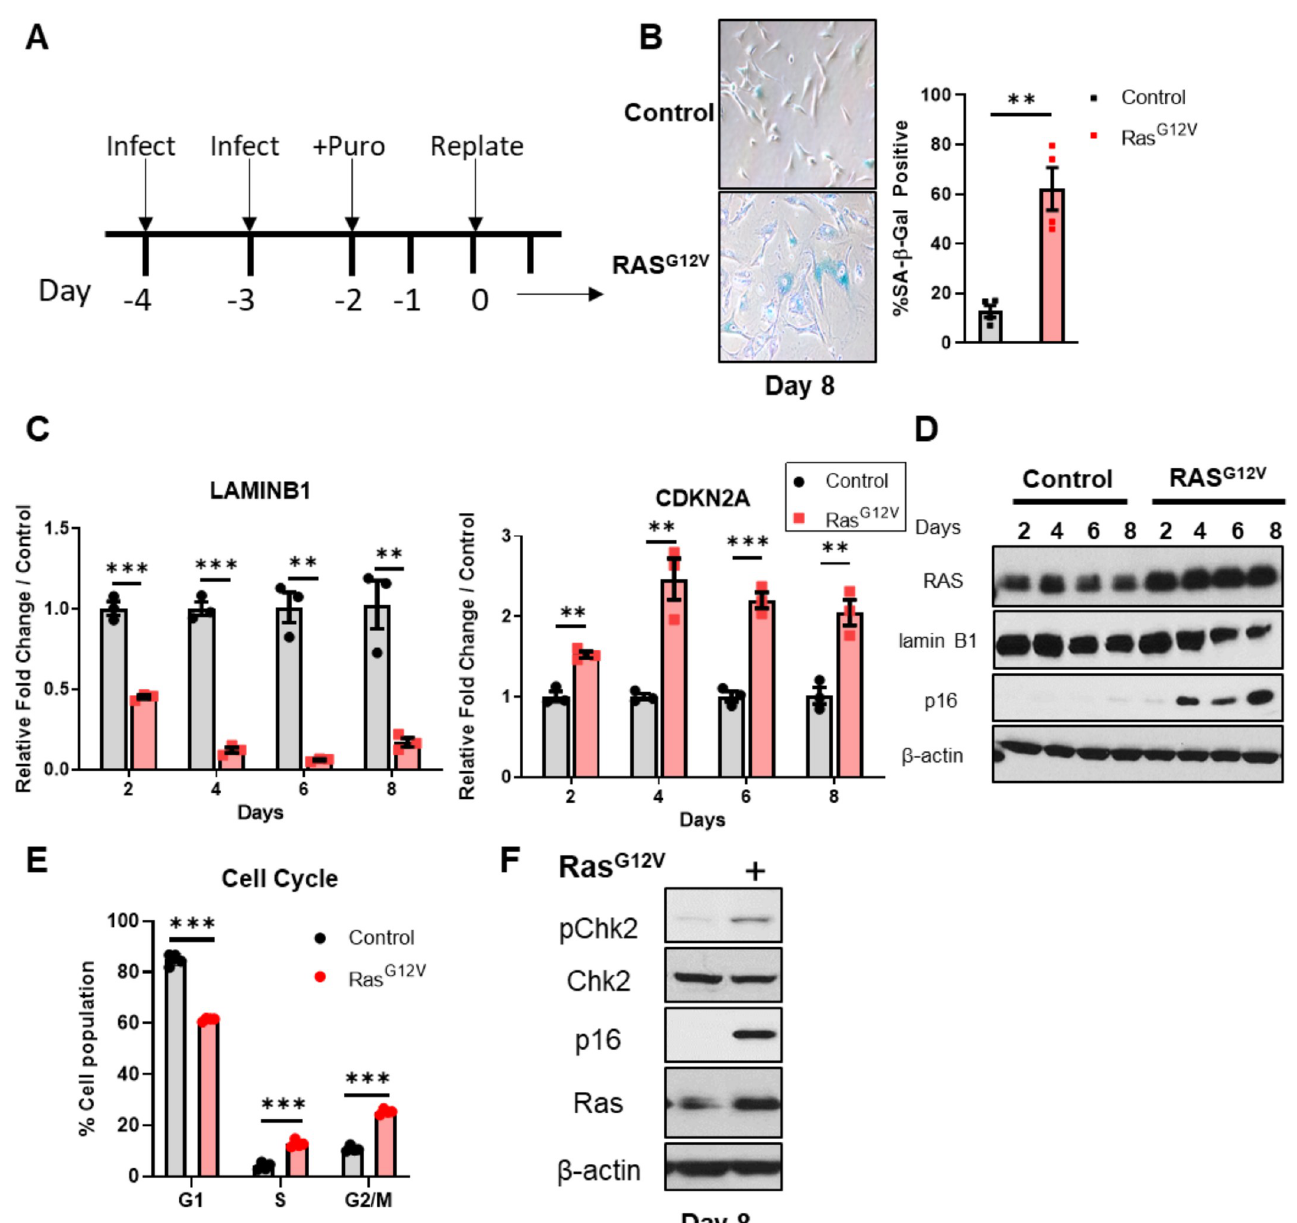
Fig 1. Ras G12V overexpression in h TERT -BJ5a cells induces a senescent phenotype. (A) Schematic of the experimental infection and selection time course. (B) hTERT BJ5a human fibroblasts were infected with pBabe retrovirus empty vector (control) or encoding mutant Ras G12V . Left panel : SA- β -galactosidase staining of BJ5a cells (Day 8) with and without Ras G12V OE. Right panel : Quantification of β -galactosidase staining (N = 3 technical replicates). Data represent mean +/- SEM. (C) mRNA expression of senescence markers LMNB1 and CDKN2A after Ras G12V OE. qRT-PCR was performed at the indicated timepoints following selection. Data represent mean +/- SEM of three biological replicates. (D) Corresponding immunoblot analysis of senescence markers LaminB1 and p16. One of three biological replicates is shown. (E) Cell cycle analyses of control and Ras G12V OE cells on Day 8. Data represent mean +/- SD of three biological replicates. (F) Checkpoint activation after Ras OE. Immunoblot analyses for Chk2 Thr38 phosphorylation was performed on Day 8. One of three biological replicates is shown.